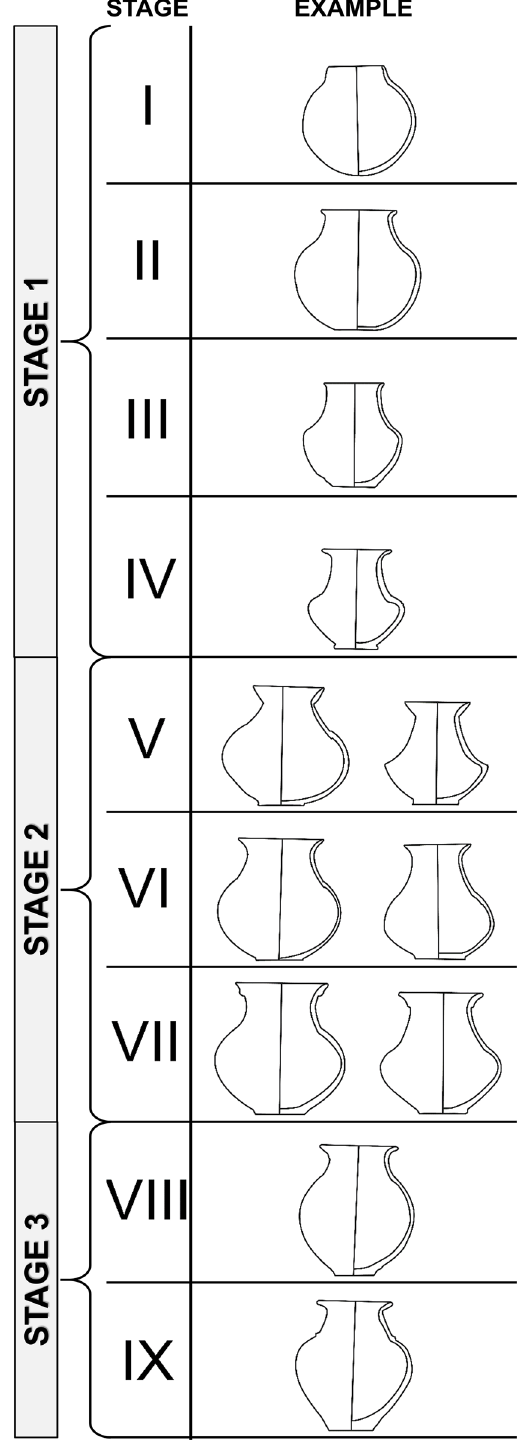
Figure 2: 9 Stage chronology of initial/early Yayoi period tsubo pots. Nine stages are divided into three major morphological stages ( modi fi ed from Loftus, 2021 )